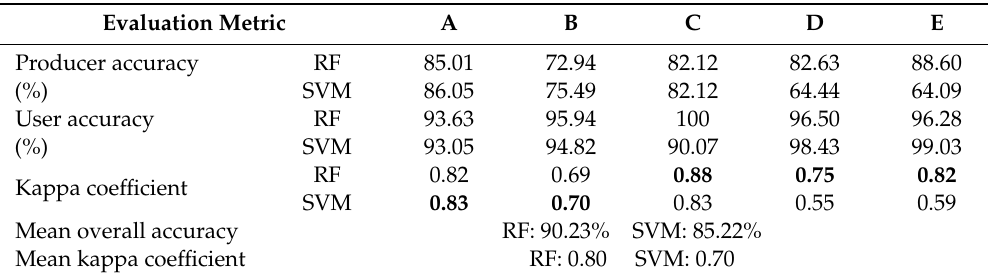
Table 4. Classification accuracy of random forest (RF) and support vector machine (SVM).